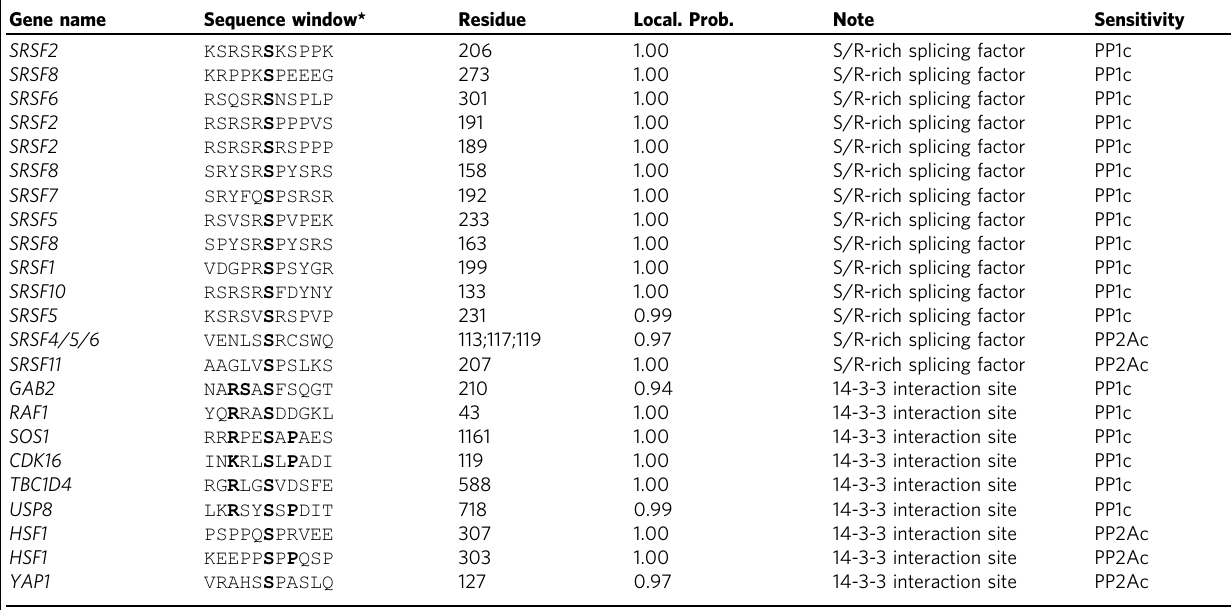
*Bold letters highlight the phosphorylation site and residues of the 14-3-3 consensus motif. Serine/Arginine-rich splicing factors with the sequence window of − 5 to + 5 relative to pSer signi fi cantly decreased exclusively by PP1c or PP2Ac (top). These data are based on Fig. 5b and Supplementary Data 2. Known 14-3-3 interaction sites (annotated in PhosphositePlus) exclusively dephosphorylated by PP1c or